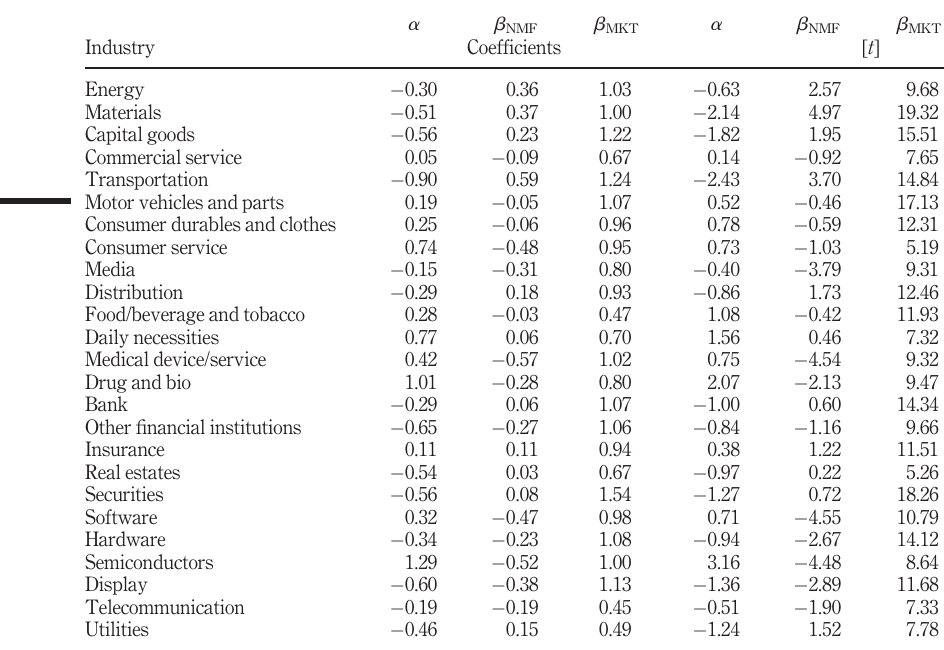
Table 8. Regression results of industry portfolios on duration